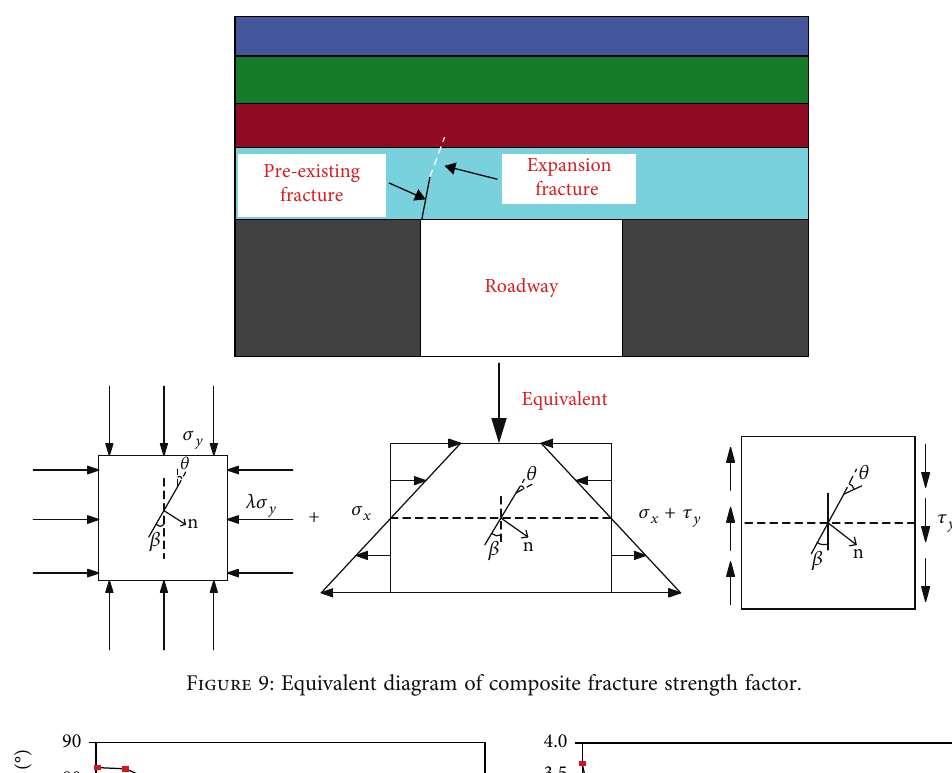
Figure 9: Equivalent diagram of composite fracture strength factor.